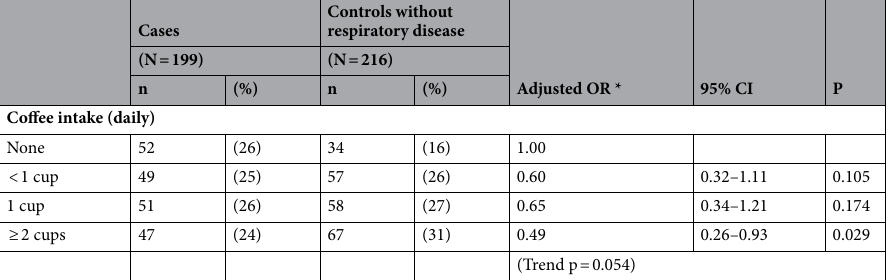
Table 3. Odds ratio of coffee intake for pneumonia in Sub analysis (1). *Variables included in model: sex, age, vaccination status (pneumococcal, influenza), BMI, underlying disease (hypertension, diabetes mellitus, heart